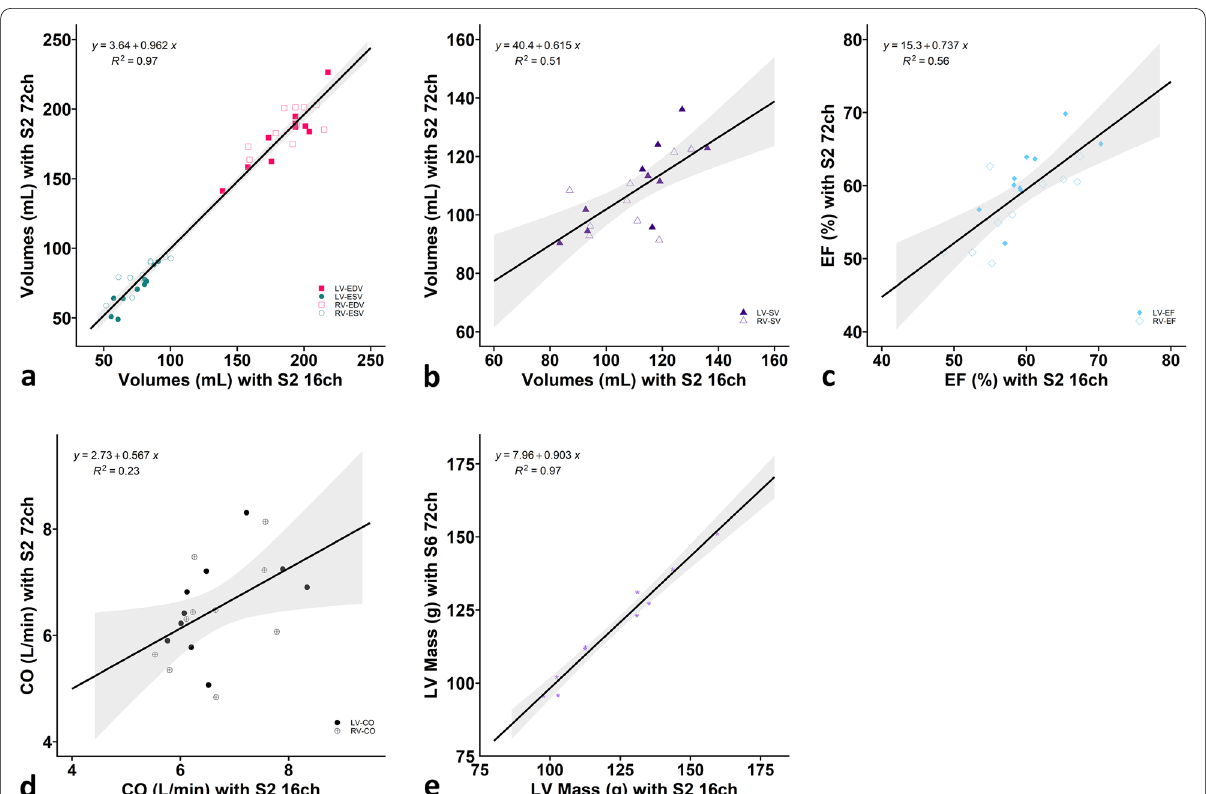
Fig. 5 Linear regression plots including 95% confidence intervals comparing ( a ) left ventricular (LV) and right ventricular (RV) end-diastolic volumes (EDV) and end-systolic volumes (ESV), ( b ) LV and RV stroke volumes (SV), ( c ) LV and RV ejection fractions (EF), ( d ) LV and RV cardiac outputs (CO), and ( e ) LV mass measured with SENSE-2 16-channel receiver array (7 breath-holds) as reference compared to SENSE-6 72-channel receiver array (2 breath-holds). ch Channel, CS Compressed sensitivity encoding, S Sensitivity